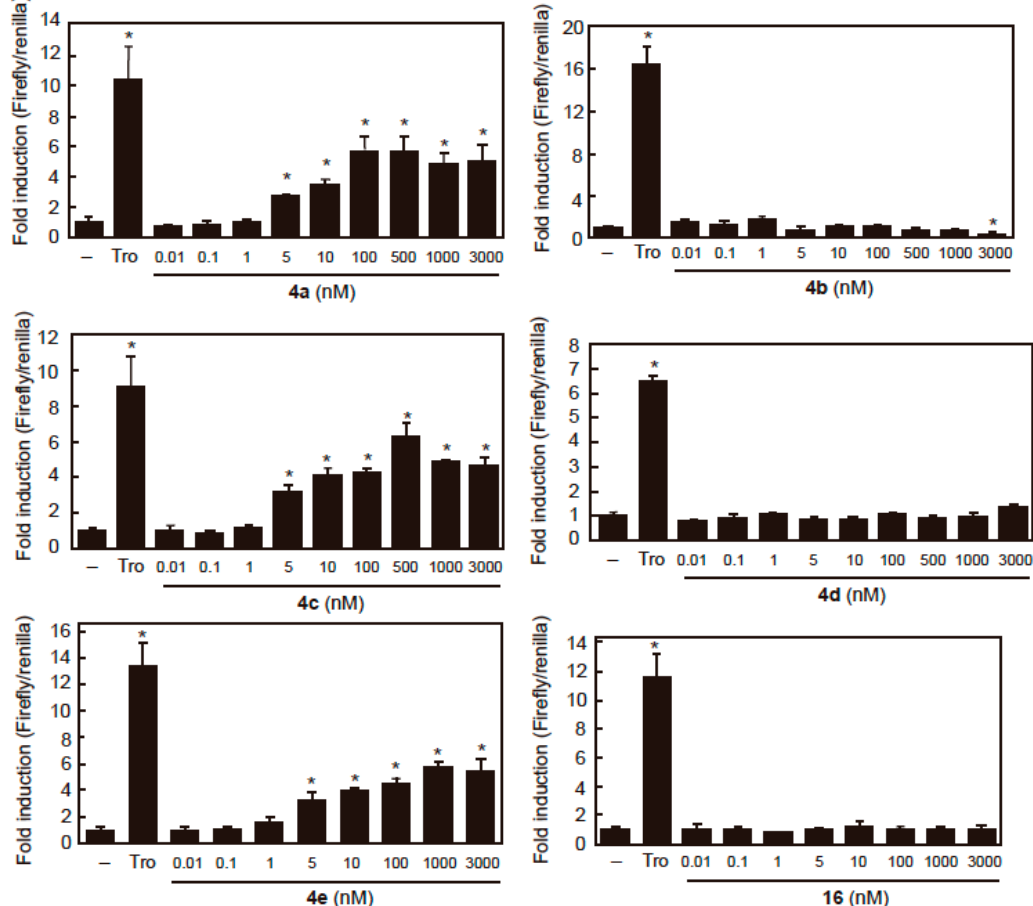
Figure 2. Transactivation potentials of PPAR γ by 4a , b , c , d , e , and 16 . The luciferase reporter assay was performed in HepG2 cells transiently cotransfected with pGal4-humanPPAR γ LBD plasmid, pUAS-tk-Luc reporter, and pGL4.74[hRluc / TK] (Promega). Firefly luciferase activities were normalized to Renilla luciferase activities. Vehicle control data are denoted as 1. HepG2 cells were treated with the vehicle (0.1% DMSO, shown as –), troglitazone (10 µ M, shown as Tro), 4a , b , c , d , e , or 16 for 6 h. All the results are presented as the mean ± SD (n = 3) of three independent experiments. * p < 0.001, compared with vehicle